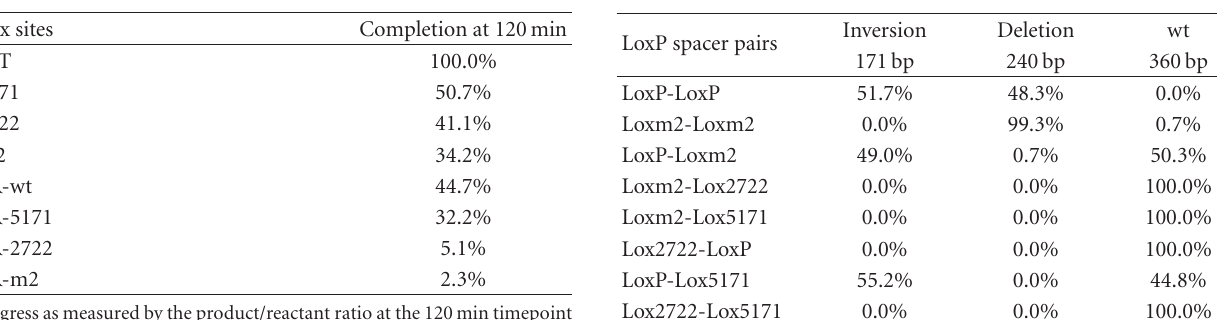
Table 1: Reaction progress at 120min. Table 2: Variant